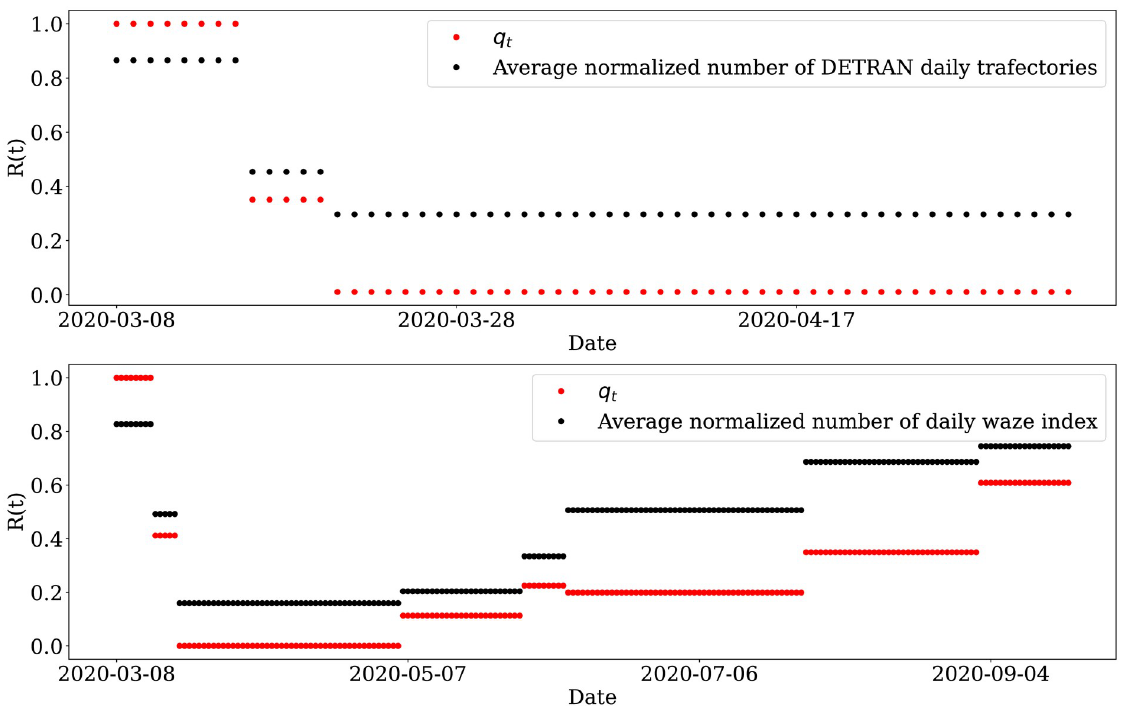
Fig 14. Sensitivity analysis. Comparison between our mobility quantifier with some real mobility data used in our work.